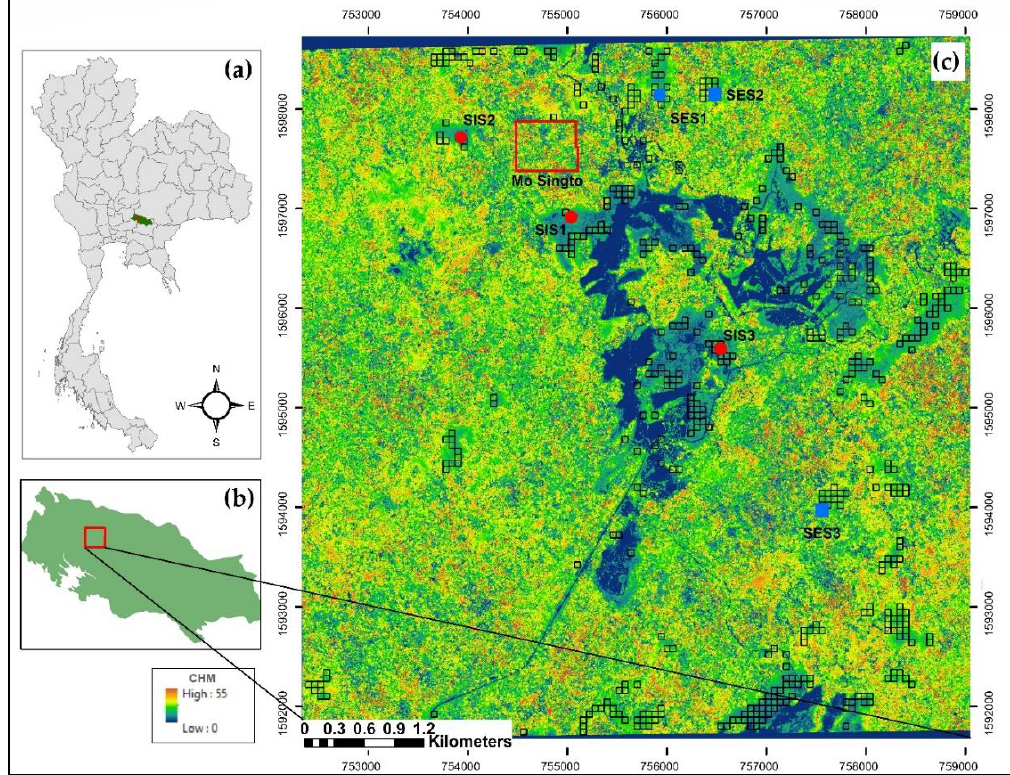
Figure 1. Location of the study site in Thailand ( a ) and in the Khao Yai area ( b ). The map ( c ) represents the canopy height in the study site with three stand initiation stage plots (SIS; red dots), three stem exclusion stage plots (SES; blue square), Mo Singto or permanent old growth stage plot (OGS; red rectangle), and 444 Landsat time-series plots (LTS; black squares).